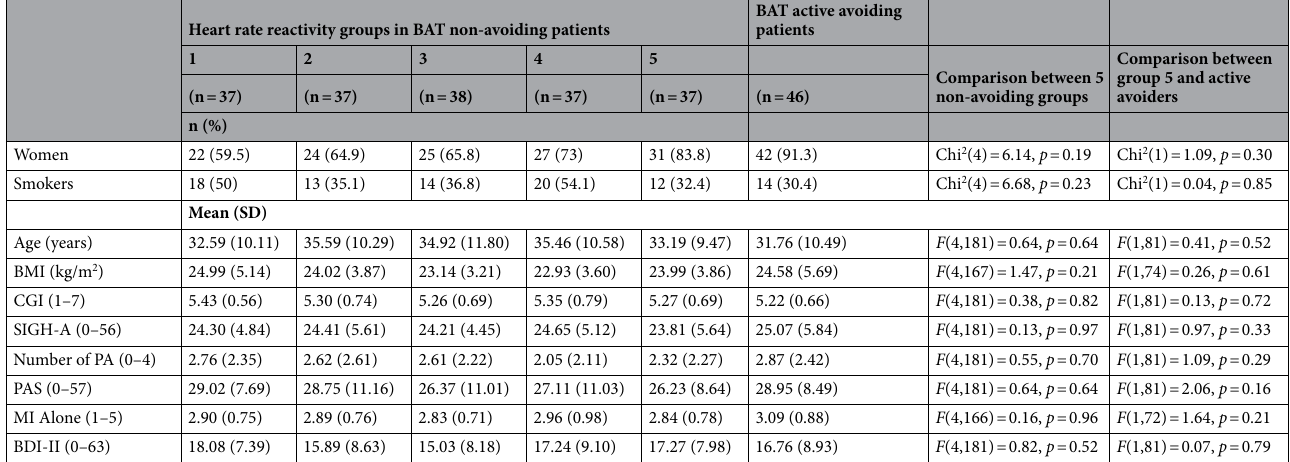
Table 1. Distribution of gender, smoking status, age, BMI and symptom severity during baseline assessment in the six study groups. Due to missing values, BMI scores, MI Alone scores and smoking status were available only for 213 patients (group 1: n = 33; group 2: n = 33; group 3: n = 36; group 4: n = 35; group 5: n = 35; active avoiders: n = 41), 211 patients (group 1: n = 36; group 2: n = 34; group 3: n = 34; group 4: n = 33; group 5: n = 34; active avoiders: n = 40) and 231 patients (group1: n = 36; group 2: n = 37; group 3: n = 38; group 4: n = 37; group 5: n = 37, active avoiders: N = 46), respectively. A patient was classified as a smoker if on average at